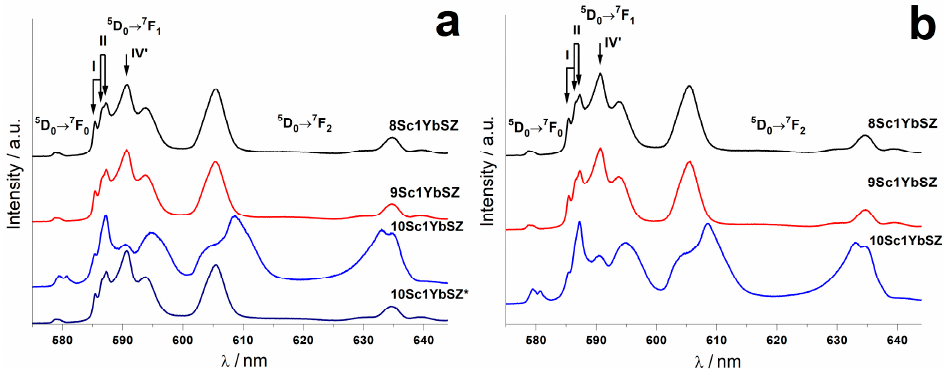
Figure 4. Luminescence spectra of crystals from the (ZrO 2 ) 0.99- х (Sc 2 O 3 ) х (Yb 2 O 3 ) 0.01 series before ( a ) and after ( b ) heat treatment. (10Sc1YbSZ*—luminescence spectra for the upper part of the crystal).